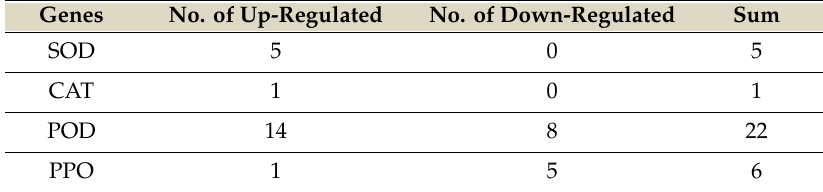
Table 1. Di ff erentially expressed genes in antioxidant enzymes. Genes No. of Up-Regulated No. of Down-Regulated Sum SOD 5 0